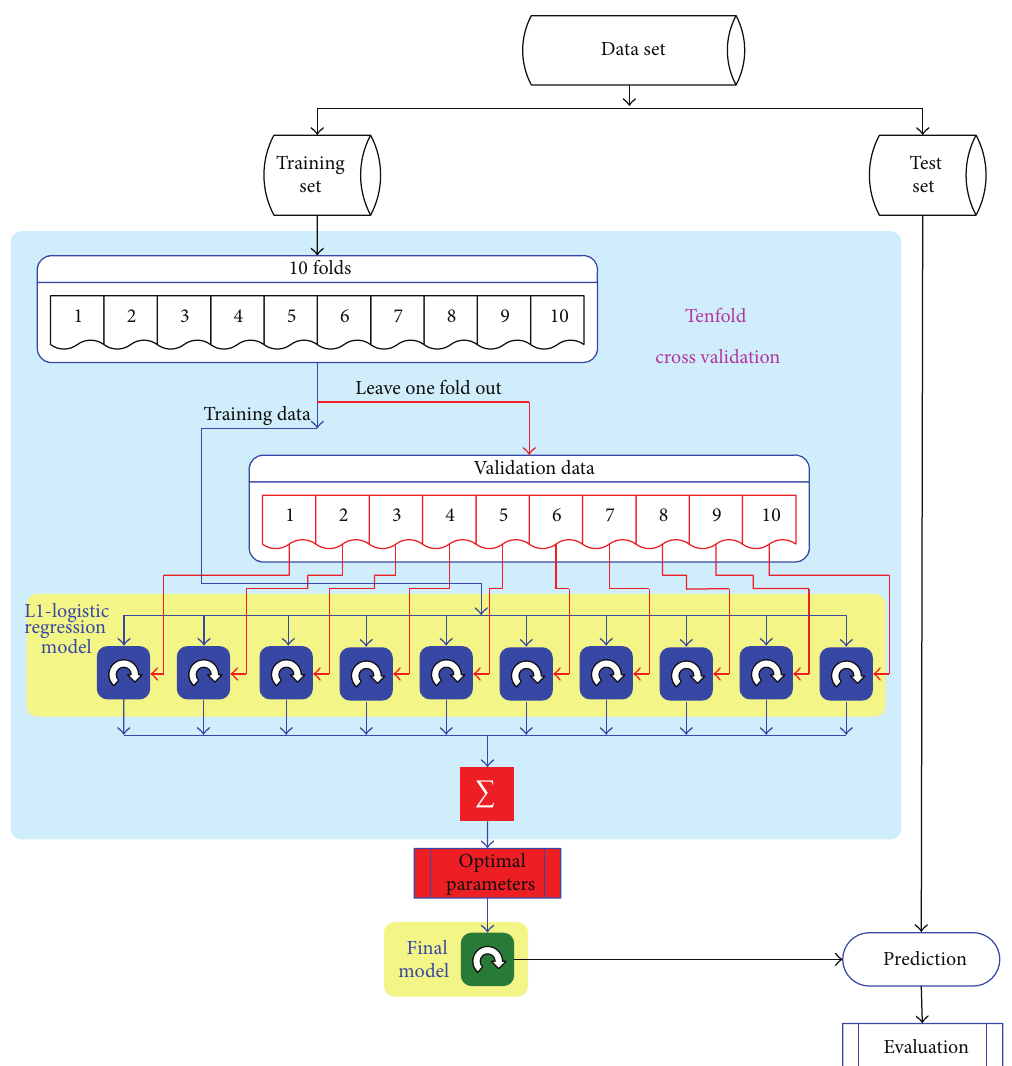
Figure 1: Data analysis flow for our experiments. Data set is evenly divided into training and test